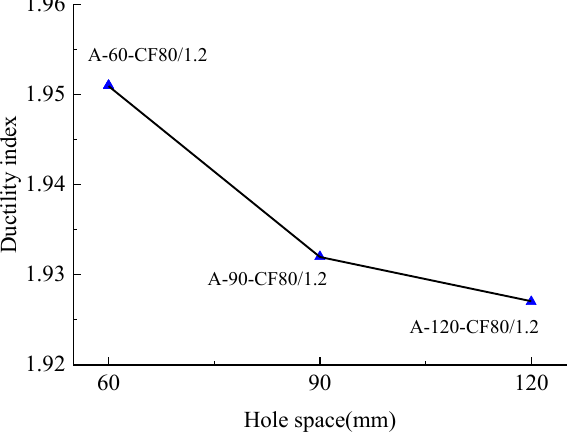
Figure 11. Changes of ductility index with the hole spacing of perfobond ribs.